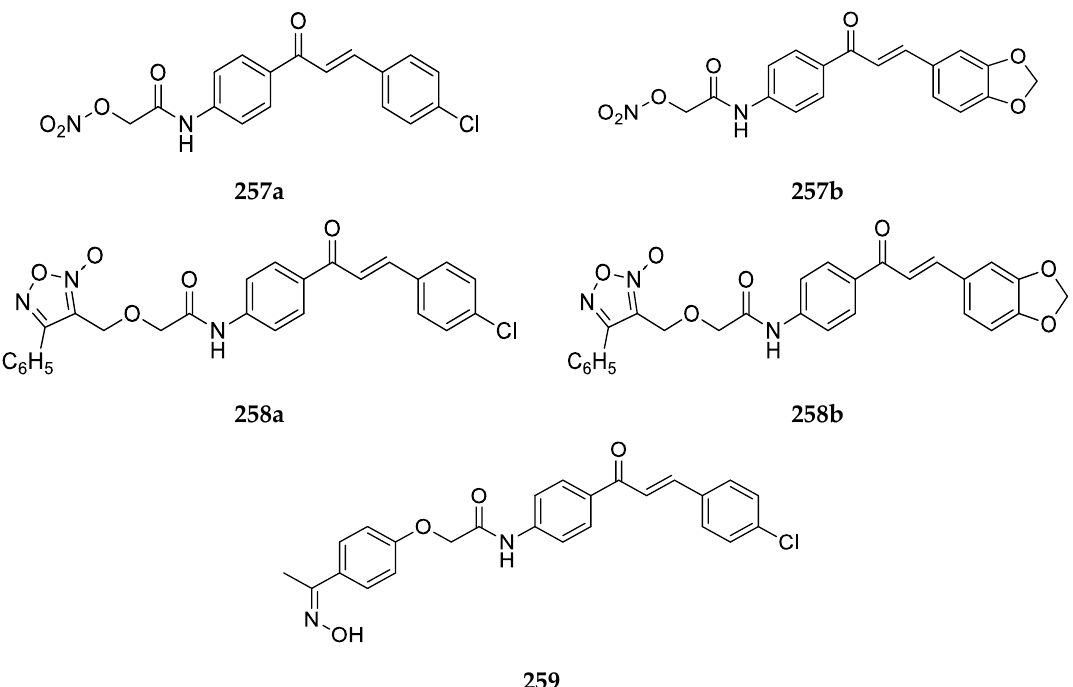
Figure 72. Chemical structure of N -acyl-4-aminochalcone derivatives with substitution on ring B.